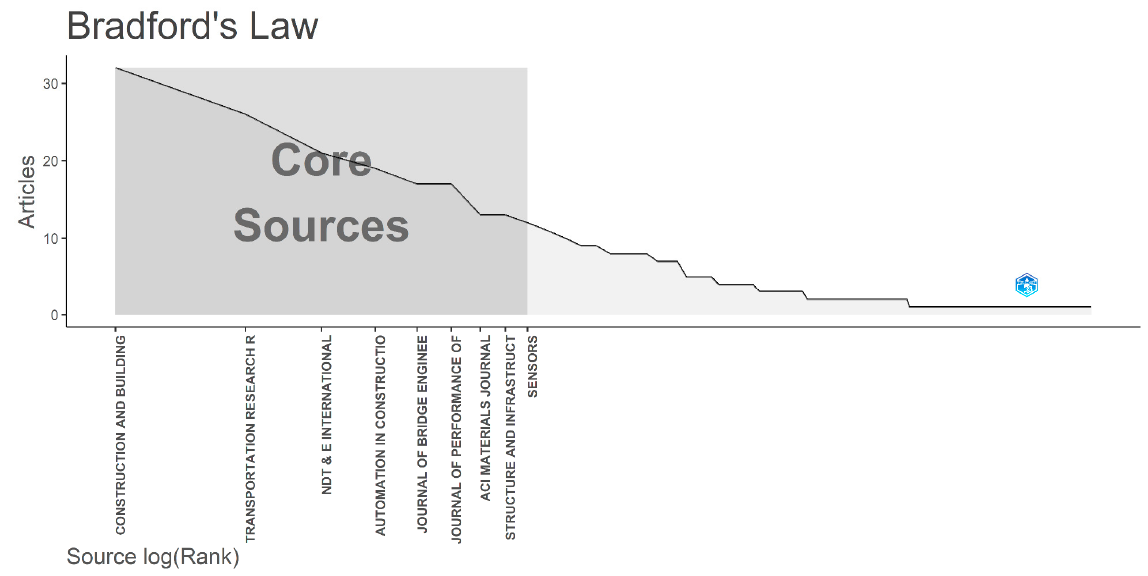
Figure 9. Core journals in CBD_NDT research according to Bradford’s law .